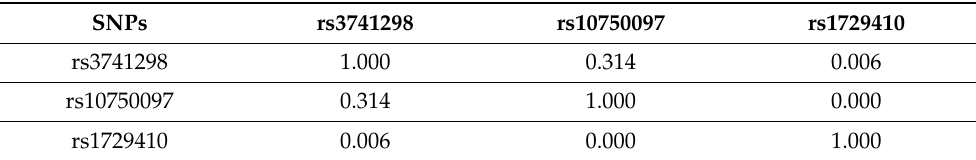
Table 2. R 2 values of the linkage disequilibrium from the CEU population (based on the results